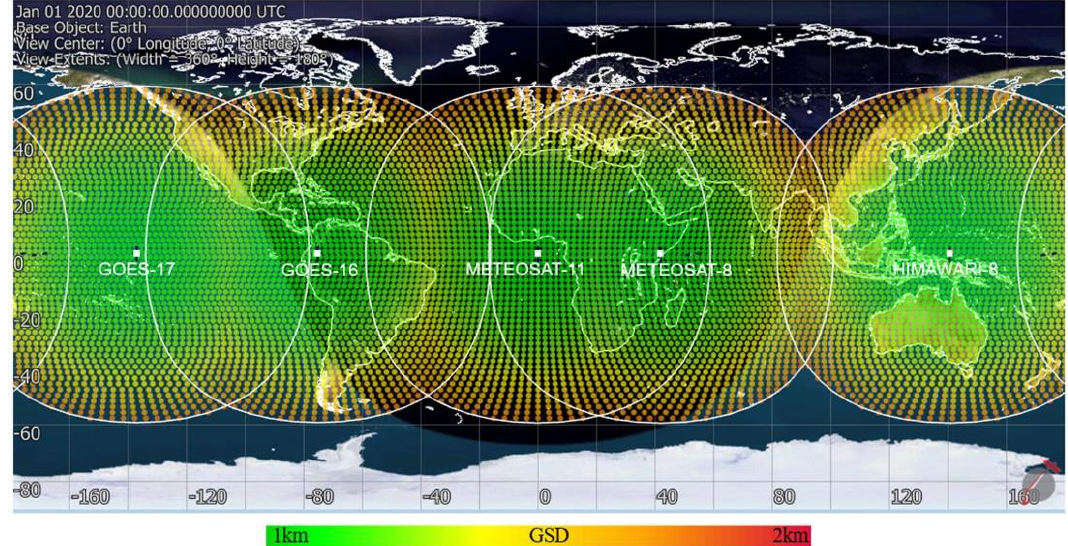
Figure 8. GEO coverage from GOES-16, GOES-17, Meteosat-8, Meteosat-11 and Himawari-8 in the ± 60 ◦ latitude band.